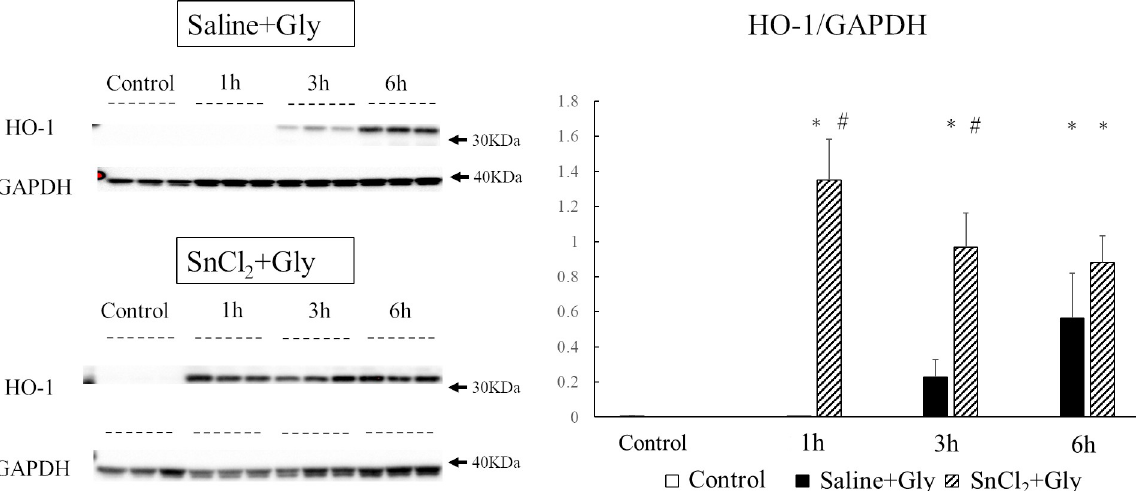
Fig 2. Changes in renal HO-1 protein expression after Gly treatment. Rats pretreated with saline or SnCl 2 (s.c.) were sacrificed 1, 3, and 6 h after Gly treatment (10 mL/kg of 50% glycerol, i.m.), and renal tissues were collected for western blot analysis. Control, untreated control rats; saline+Gly, rats pretreated with saline before Gly injection; SnCl 2 +Gly, rats pretreated with SnCl 2 before Gly injection. The densitometric ratio between HO-1 and GAPDH was calculated. Data are expressed as the mean ± SD. � p < 0.05 vs control group. #p < 0.05 vs saline+Gly group.